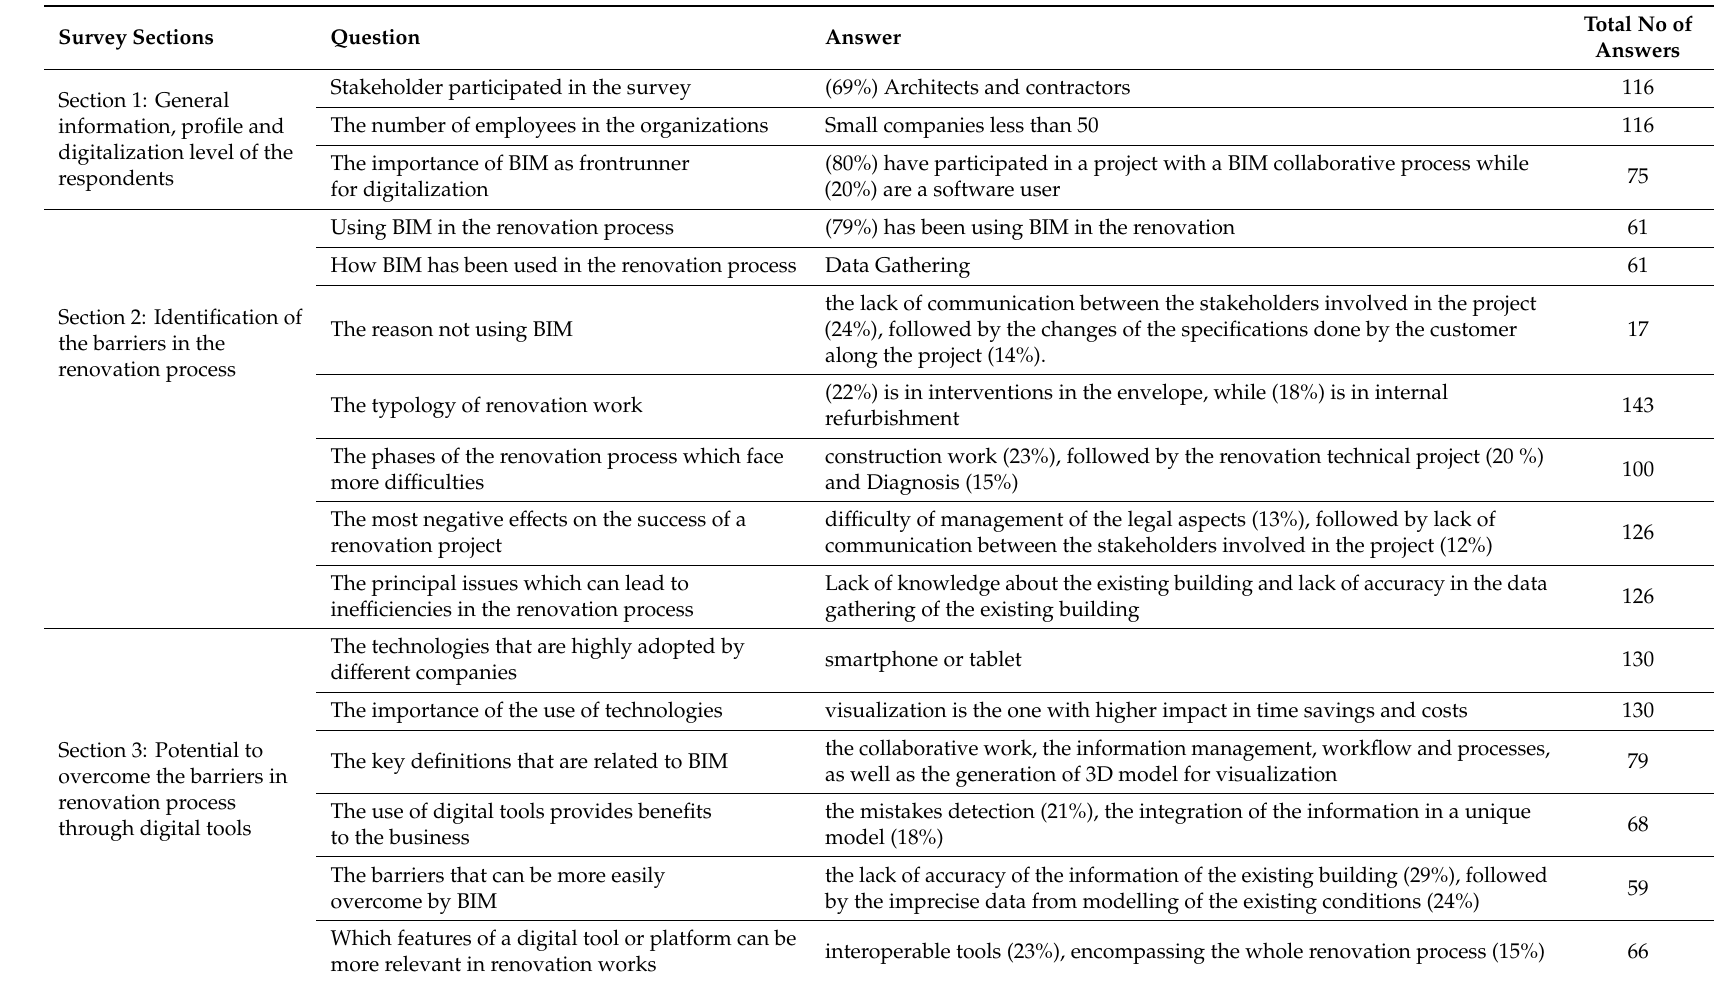
Table 1. Summary of the survey